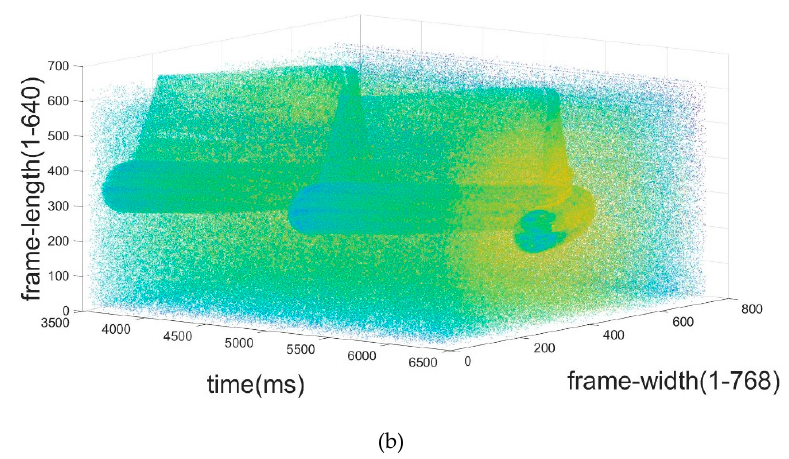
Figure 8. Filtering result of Liu’s filter with subsample factor of 4: ( a ) is the result of denoising and ( b ) is the filtered noise.